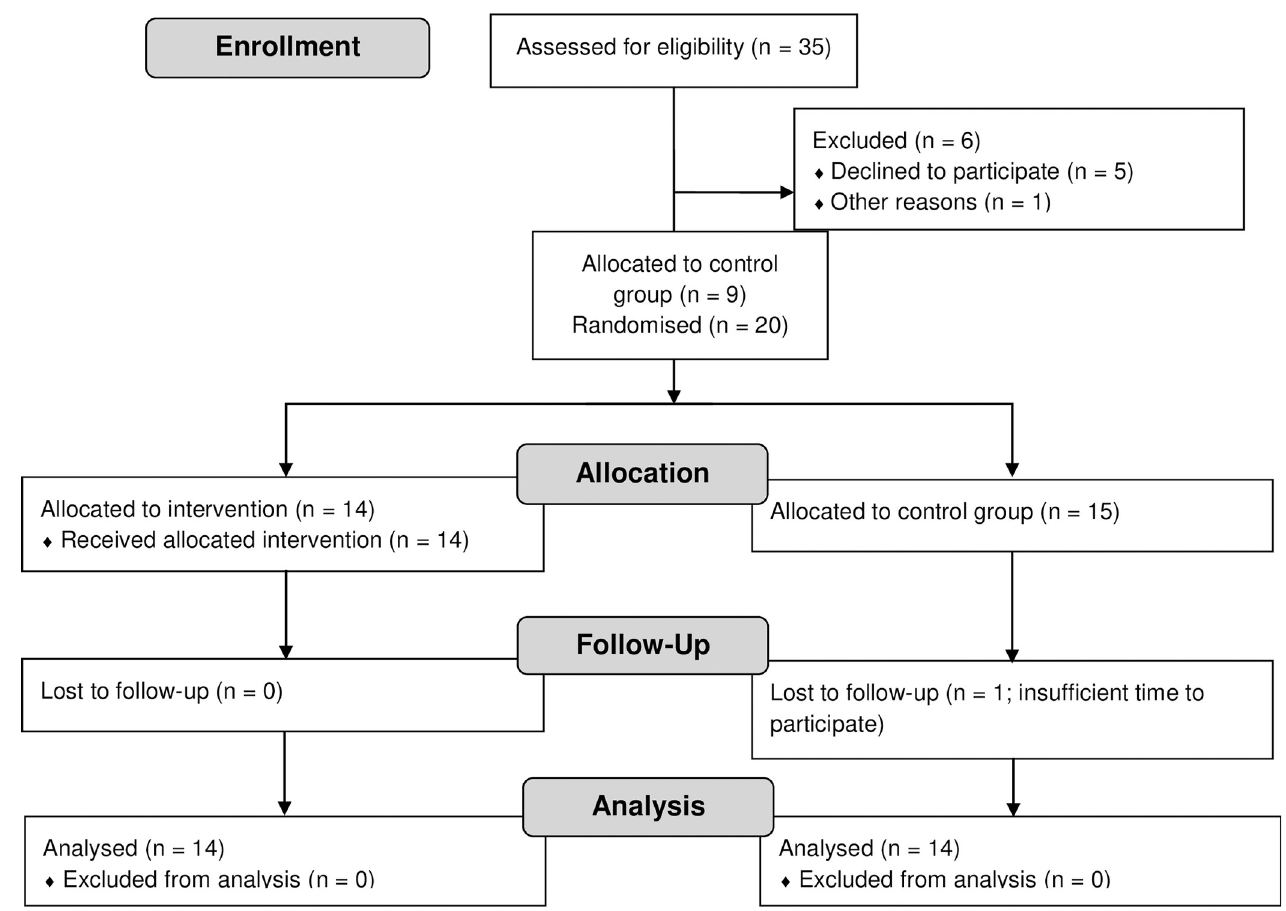
Fig 1. Participant allocation